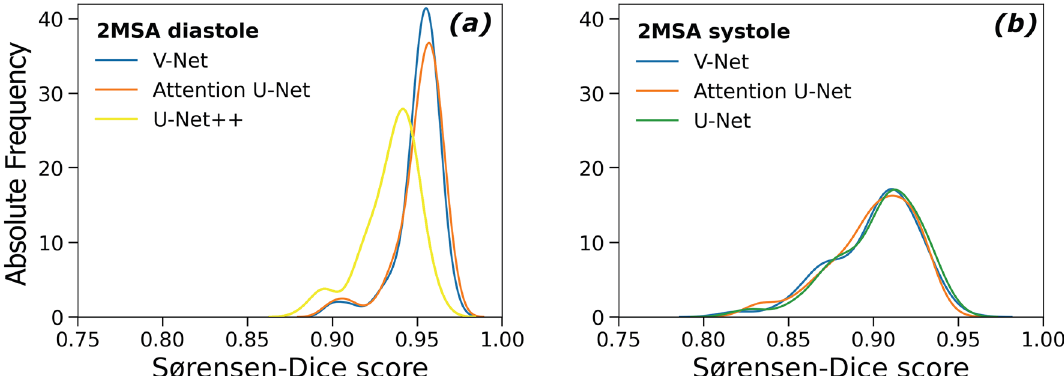
Figure 1. Sørensen-Dice score absolute frequency distribution for 2MSA models for pooled Study 5 and Study 6. ( a ) Diastole models (V-Net: 0.91 ± 0.072, Attention U-Net: 0.91 ± 0.080, U-Net + + : 0.90 ± 0.069). ( b ) Systole models (V-Net: 0.91 ± 0.072, Attention U-Net: 0.87 ± 0.065, U-Net: 0.87 ± 0.064).